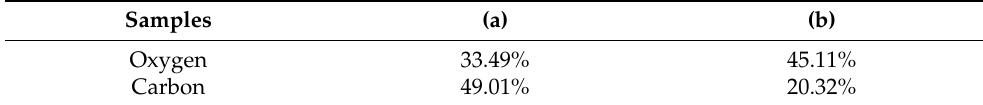
Table 3. The percentage ratios of oxygen and carbon in the samples.